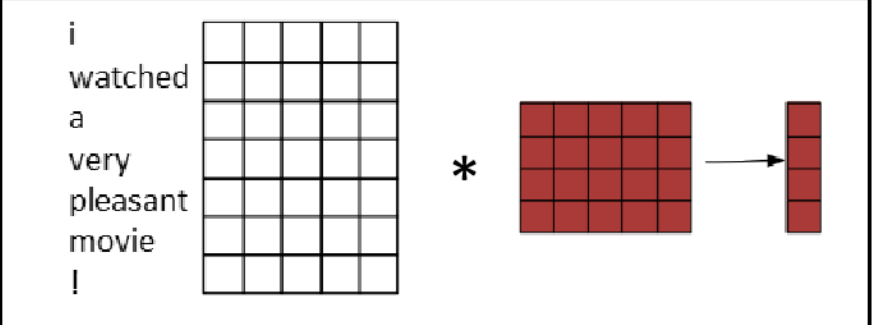
Figure 3. Wide convolution: The number of columns of the kernel is equal to the number of columns of the text matrix. The result of convolution (showed after the arrow) is a